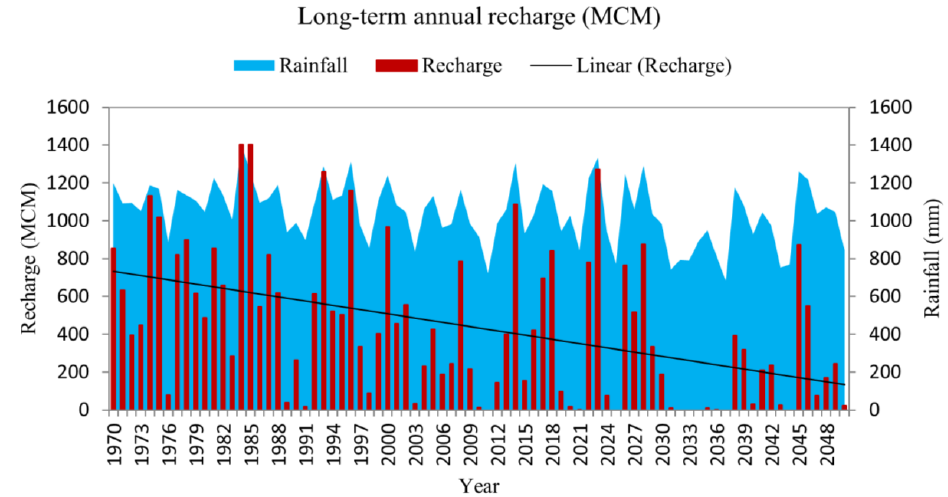
Figure 13. Long-term groundwater recharge in million cubic meters (MCM) calculated using historical and future climate data from the RCP4.5 scenario based on the Thornthwaite Monthly Water Balance and rainfall (mm) from 1970 to 2050.